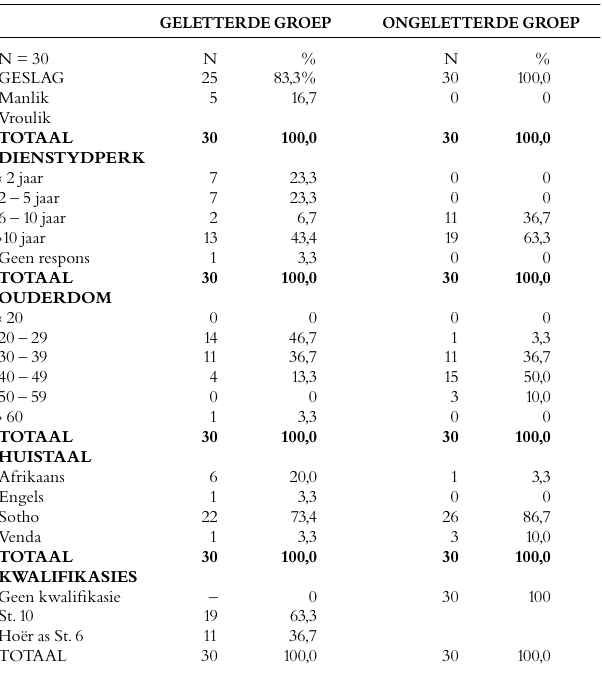
TABLE1 BIOGRAFIESE INLIGTINGVAN DIEONDERSOEKGROEPE